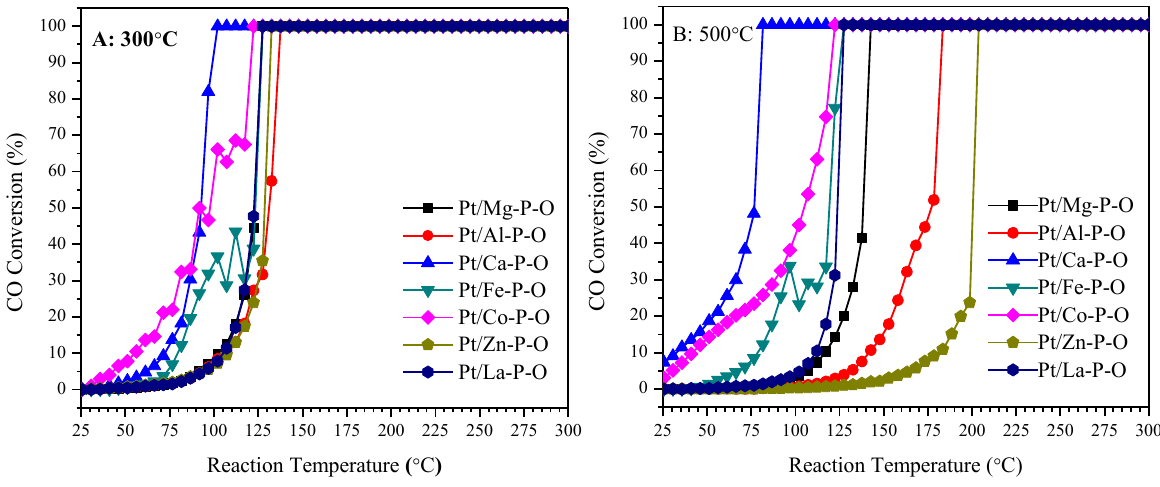
Figure 1. CO conversions on Pt/M-P-O catalysts calcined at 300 °C ( A ) or 500 °C ( B ) and then pretreated in 4% H 2 at 300 °C prior to reaction